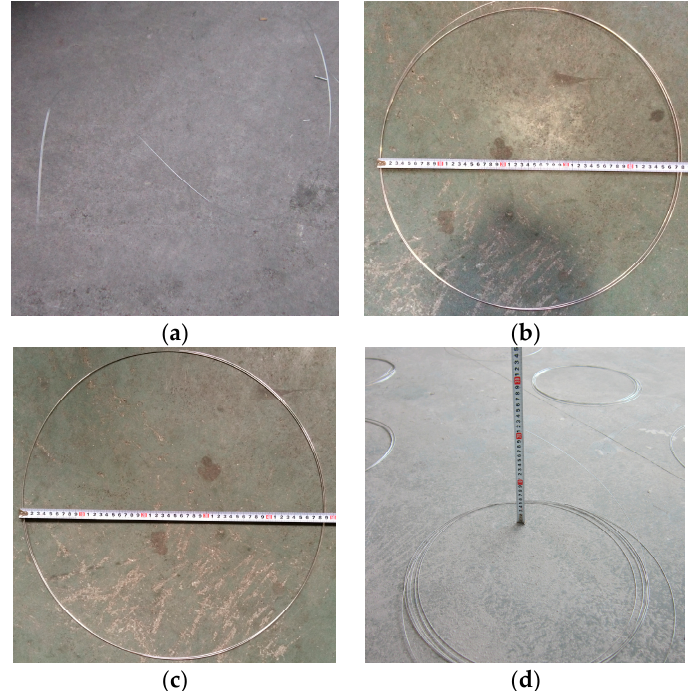
Figure 17. Measured values of helix during adjusting process: ( a ) left hand, helix = ∞ ; ( b ) left hand, helix = 65 mm; ( c ) helix = 0 mm; ( d ) right hand, helix = 215 mm.